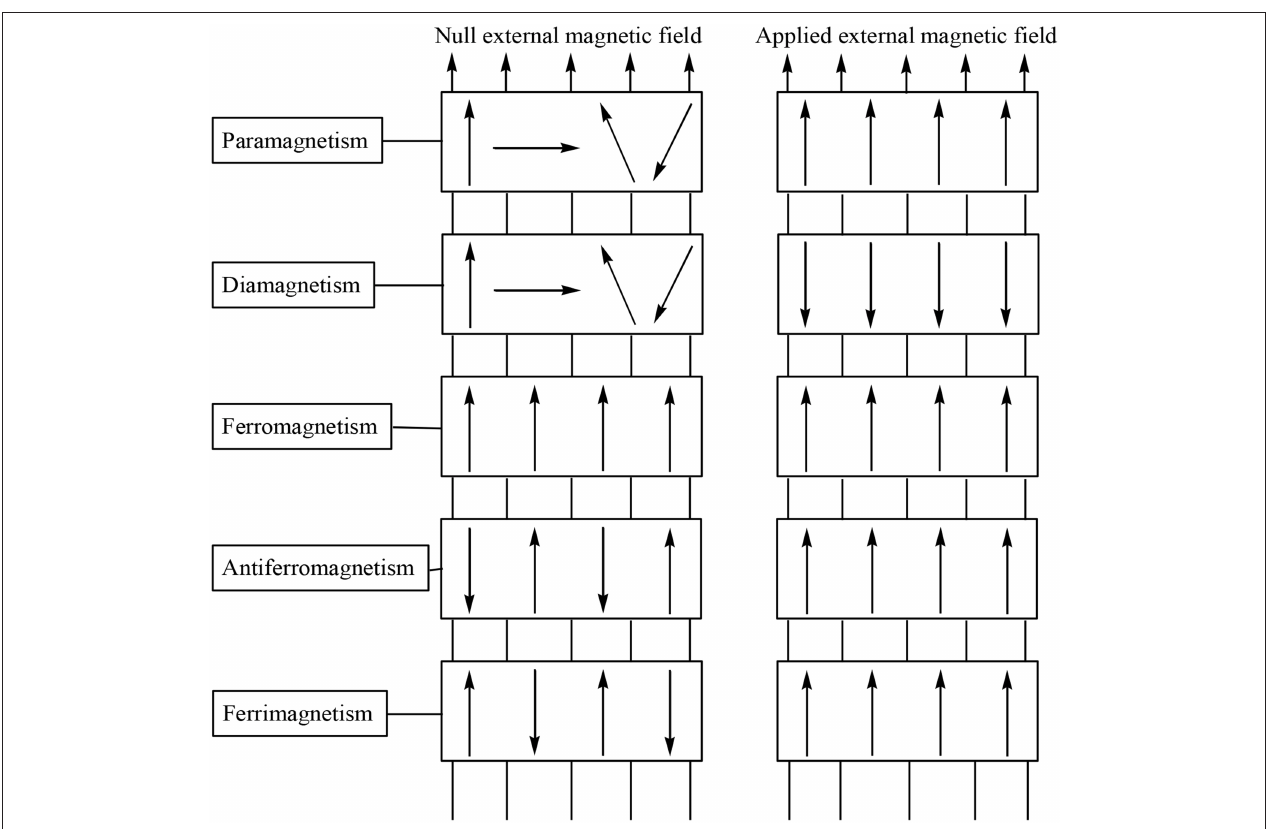
FIGURE 1 | Magnetism in the presence and absence of an external applied magnetic